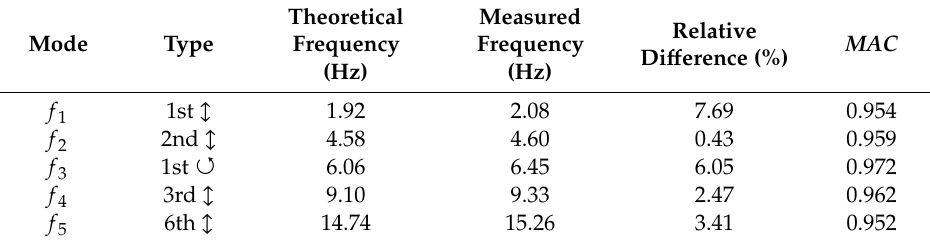
Figure 17. Stability graph of stochastic subspace identification. Table 9. Comparison between measured frequencies and theoretical frequencies.